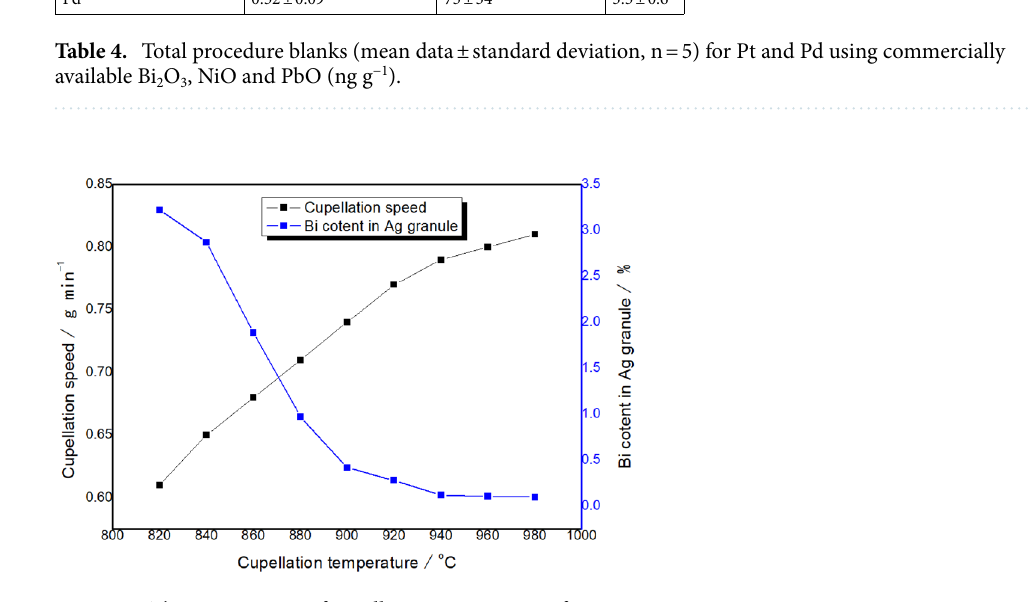
Figure 1. The optimization of cupellation temperature of Bi 2 O 3